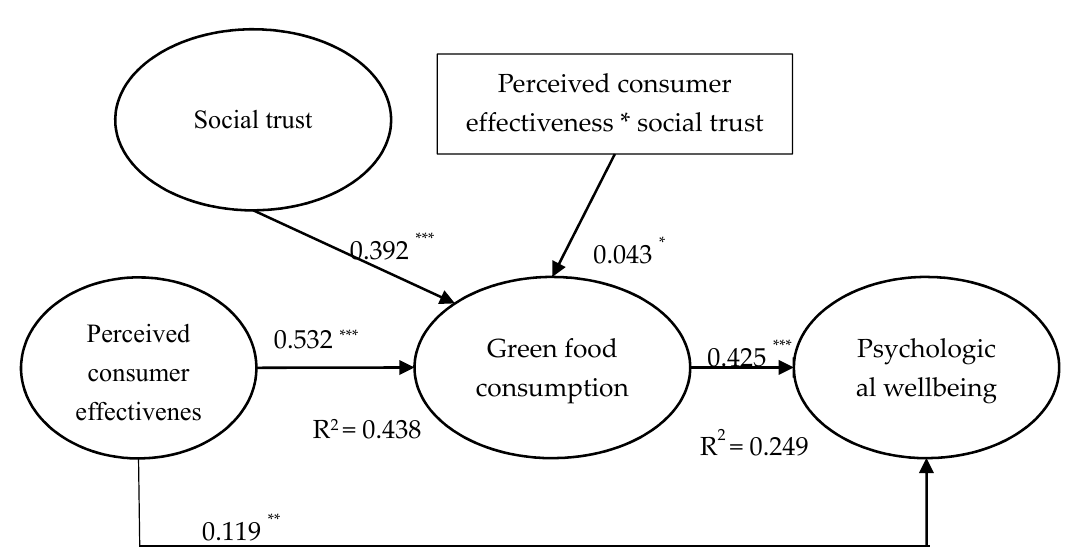
Table 5. Moderating role of social trust ( N = 514).